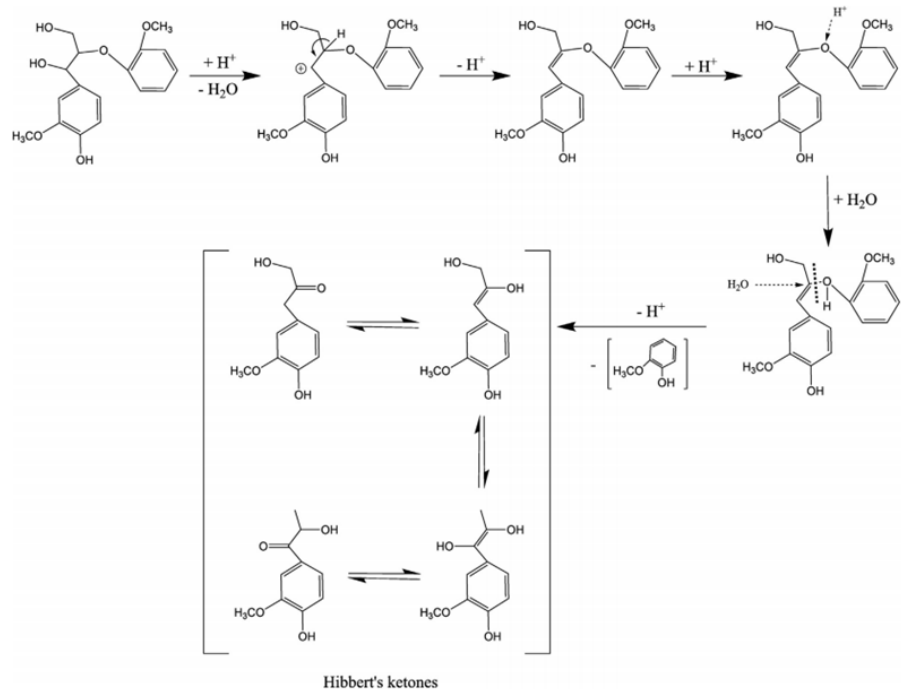
Figure 3. Cleavage of β -O-4 linkages by acid catalysts, adapted from [53].